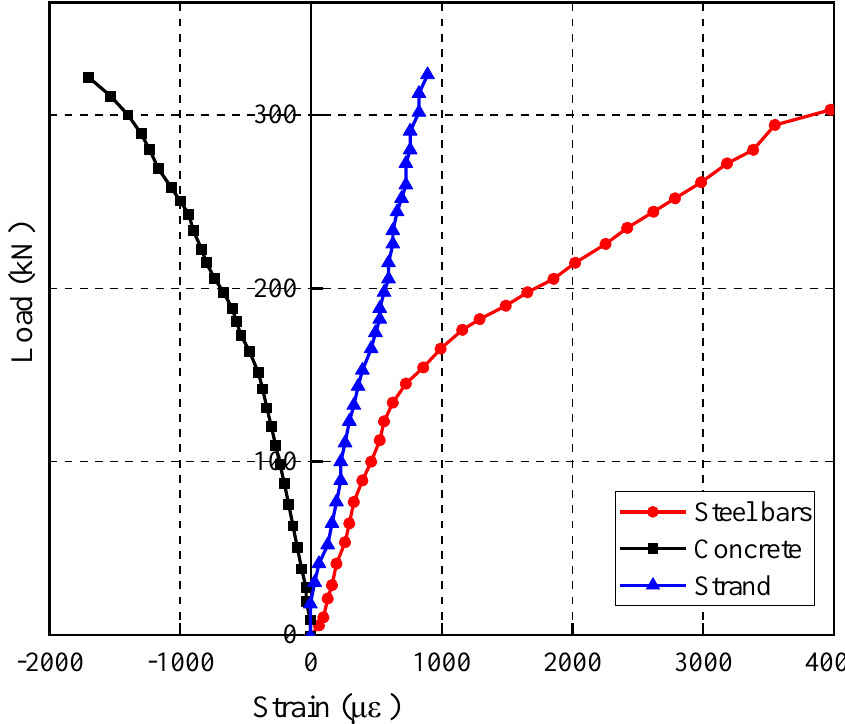
Figure 6. Load-strain curves of the beam under static loading.